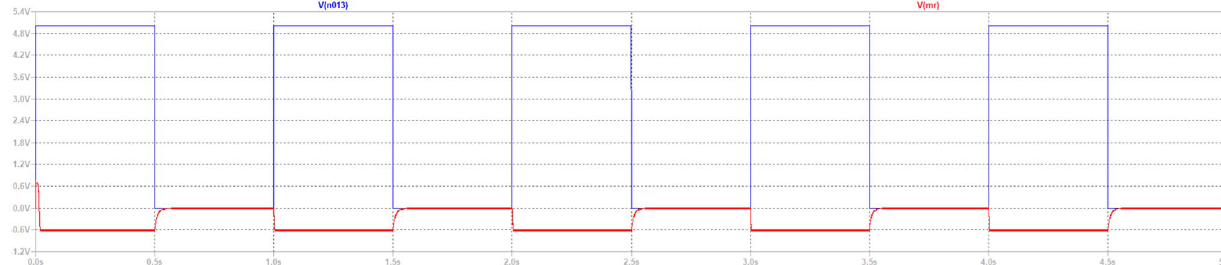
Fig. 17 Case 2: Original message (V(n013) in blue color and decoded message V(mr) in red